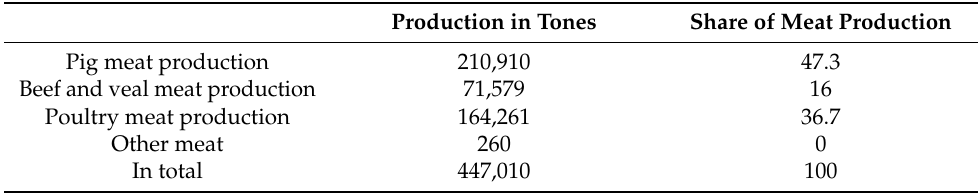
Table 1. The structure of meat production in the Czech Republic in 2018 [27]. Production in Tones Share of Meat Production Pig meat production 210,910 47.3 Beef and veal meat production 71,579 16 164,261 36.7 Other meat 260 0 447,010 100